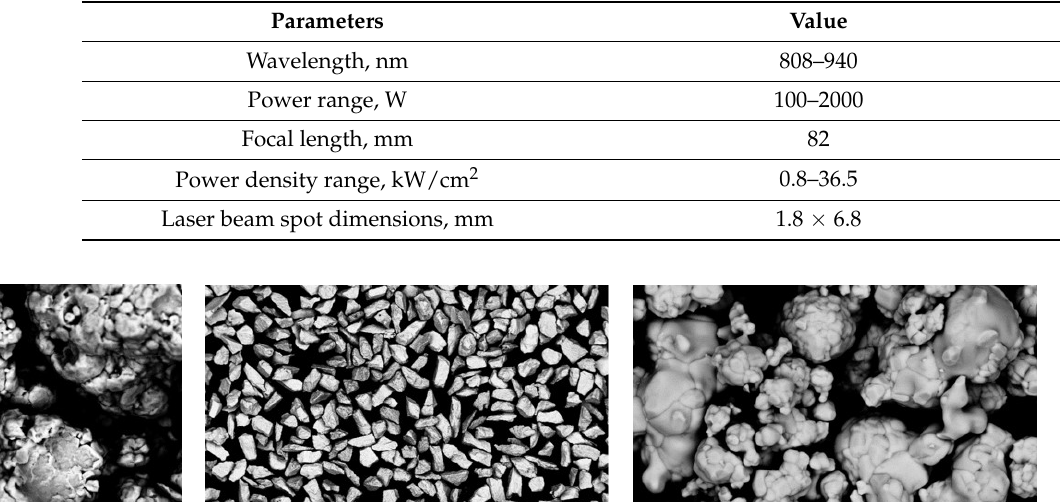
Figure 1. Scheme of laser machining setup (dimensions are given in milimetres). Table 2. Composition of Cr–WC powders and laser parameters. Table 1. Technical specifications of HPDL Rofin DL 020 laser.